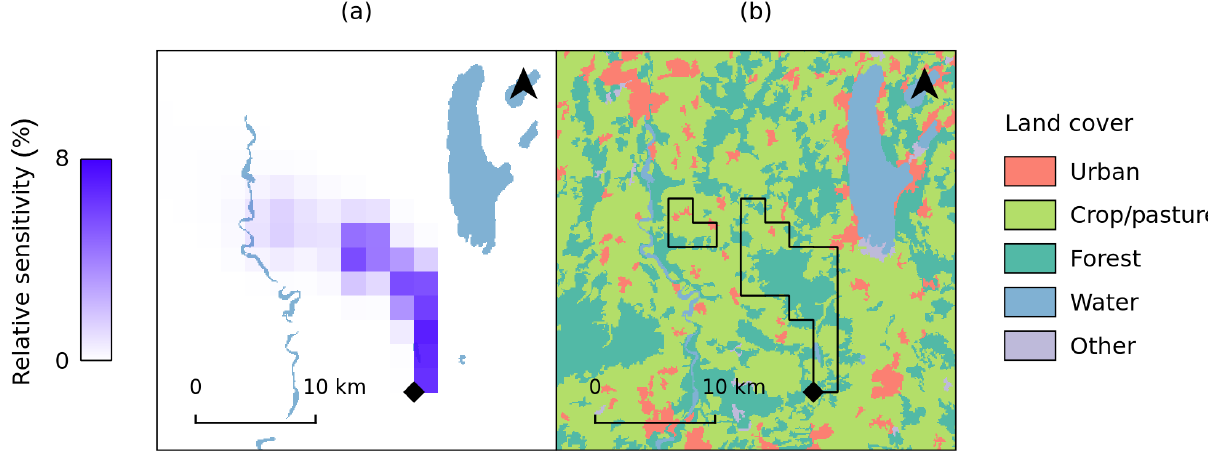
Figure 15. Same as Fig. 14, but for 9 July,